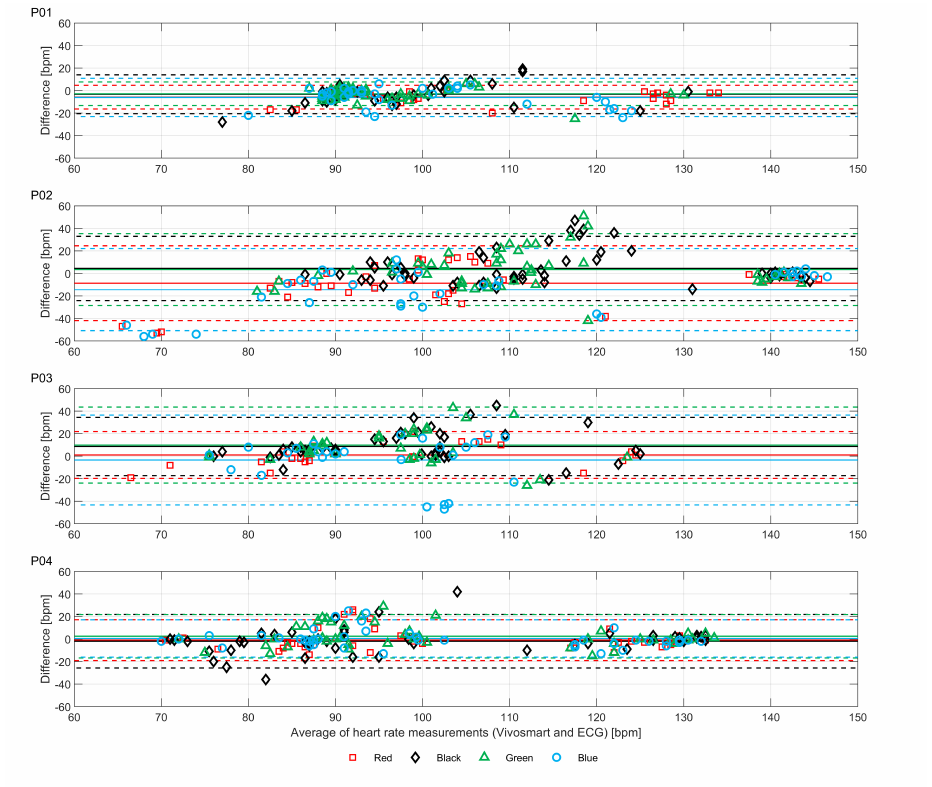
Figure 4. Bland-Altman plots for each device compared with electrocardiogram (ECG) chest strap for treadmill activities. Means (solid lines) and ± 1.96SD levels (dashed lines) for each device are